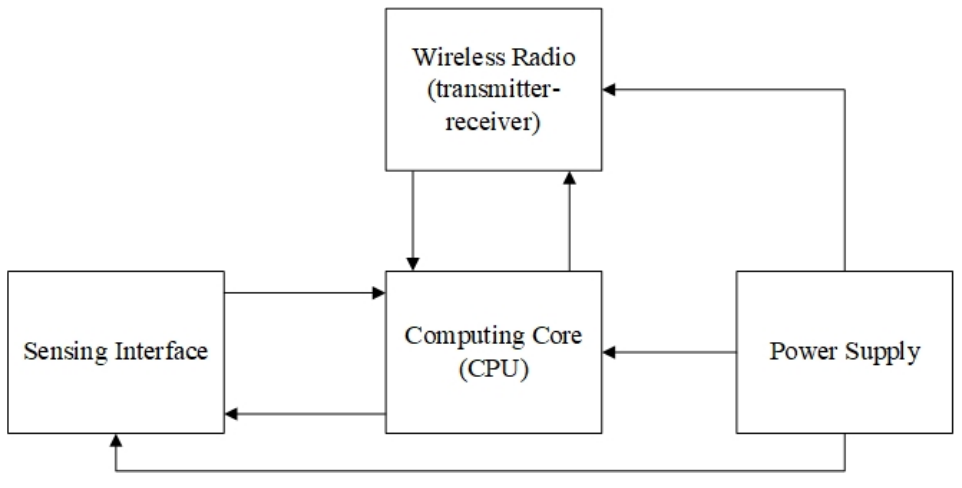
Figure 4. Wireless sensor node architecture